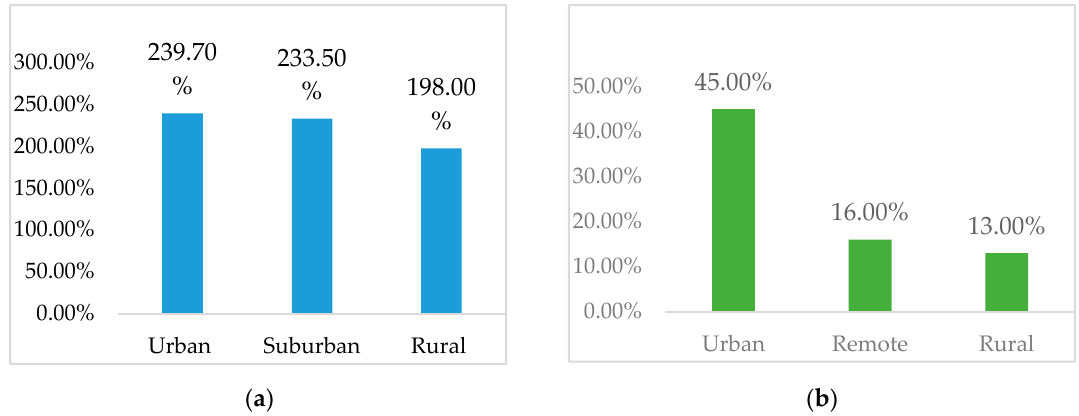
Figure 5. A comparison of HC values of Urban, Suburban and, Rural networks in two different geographical areas with different HC refernces: ( a ) The implementation of a Model Predictive Control strategy for HC investigation of three Finnish LV test networks by taking peak load as HC reference at 61.9241° N with HC of urban network being most dominating [28]; ( b ) The investigation of PV integration approaches for three reference distribution grids by taking roof-space as HC reference at 51.1657° N [81].